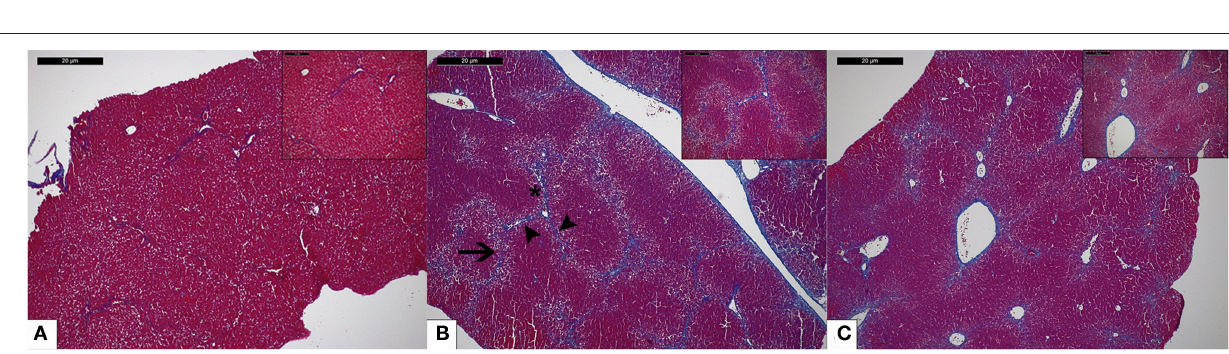
FIGURE 6 | Representative photomicrographs of liver histology of mice included in the different study groups. (A) The liver of a healthy mouse from the control group shows no fibrosis (Masson’s trichrome stain; original magnification 5x, upper right: original magnification 10x); (B) CCl 4 -induced liver fibrosis in a mouse from the untreated group. Central-central (asterisk), central-portal (arrowheads), and portal-portal (arrow) fibrous septa are shown (Masson’s trichrome stain; original magnification 5x, upper right: original magnification 10x); (C) In mice treated with OC, liver histology shows regressing fibrosis (only focal thin incomplete fibrous septa are visible) (Masson’s trichrome stain; original magnification 5x, upper right: original magnification